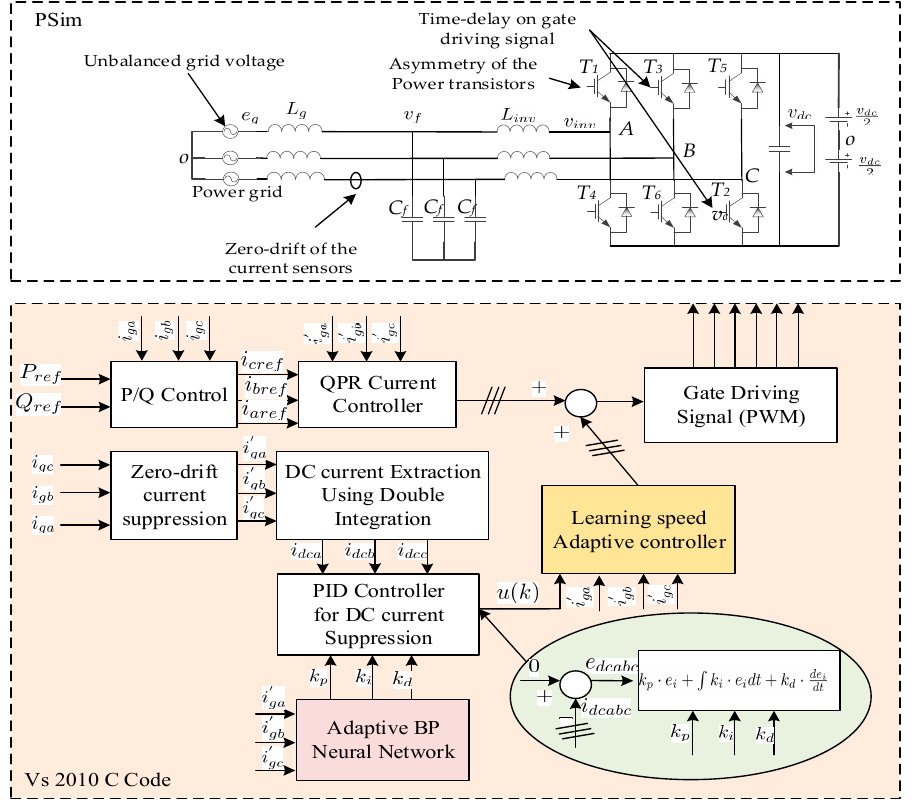
Figure 3. Block diagram of the proposed adaptive BP-PID controller for dc component suppression.